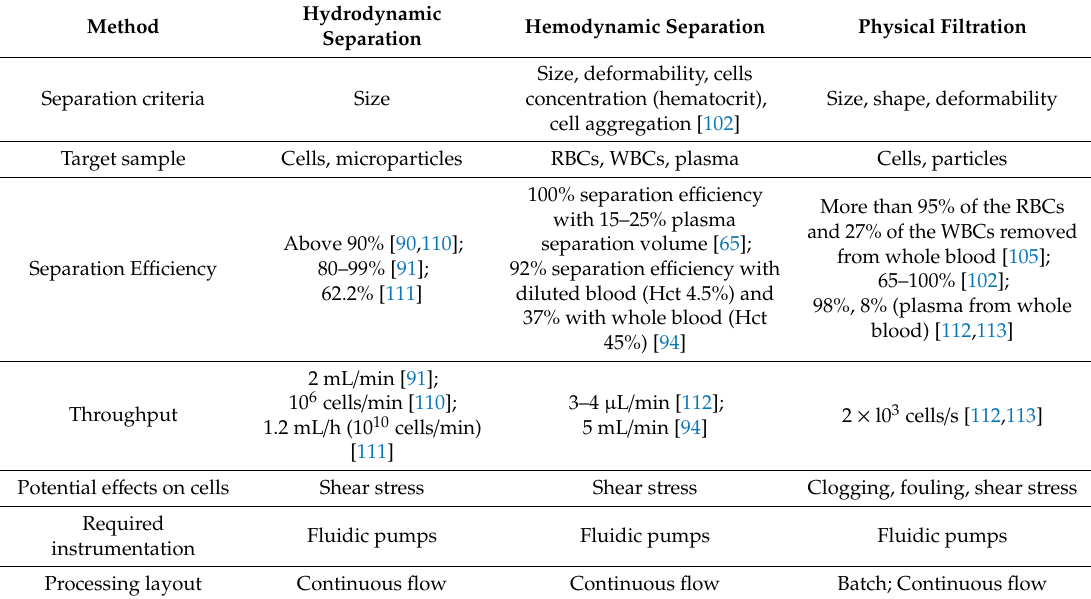
Table 3. Comparison between the passive separation